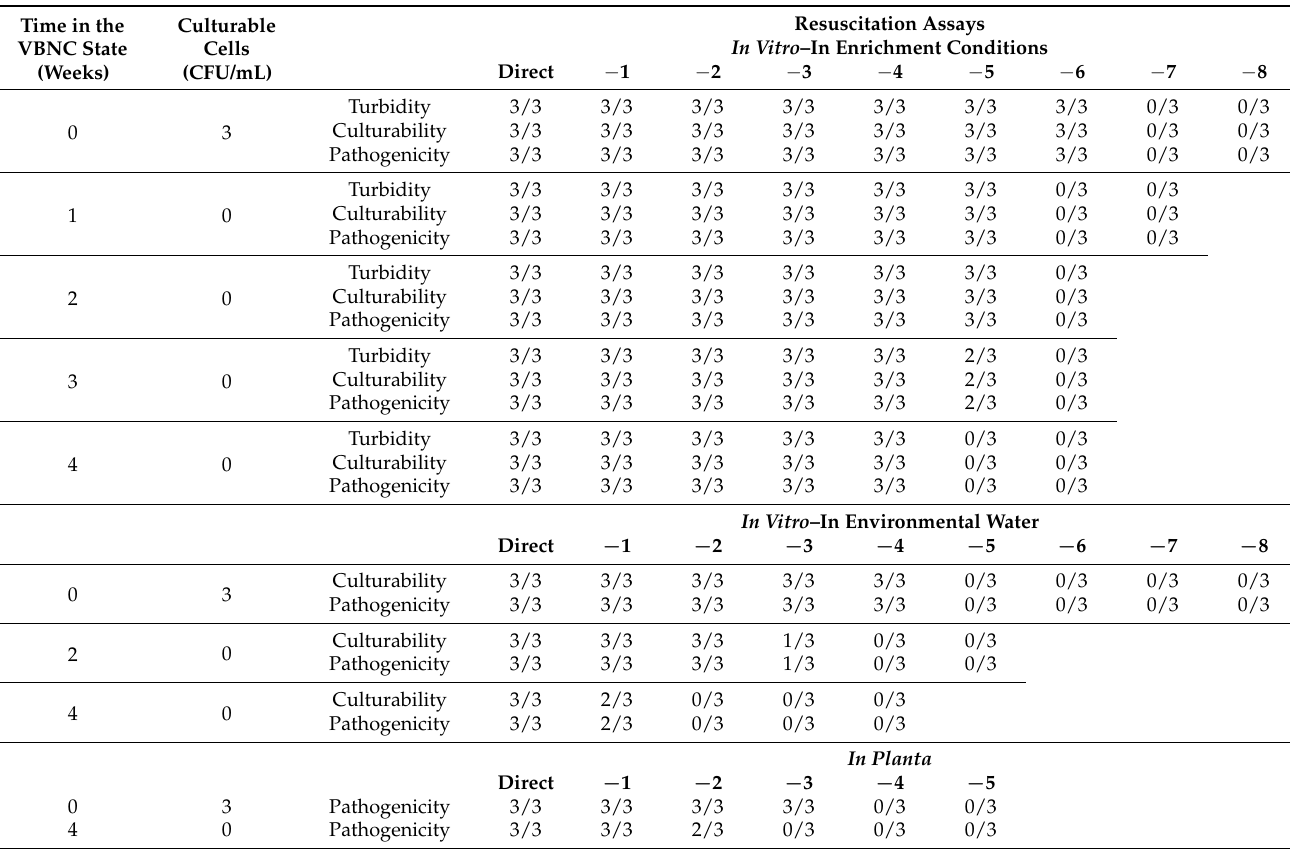
Table 1. Resuscitation of Ralstonia solanacearum strain IVIA-1602.1 previously induced to the VBNC state in environmental water microcosms at 4 ◦ C.